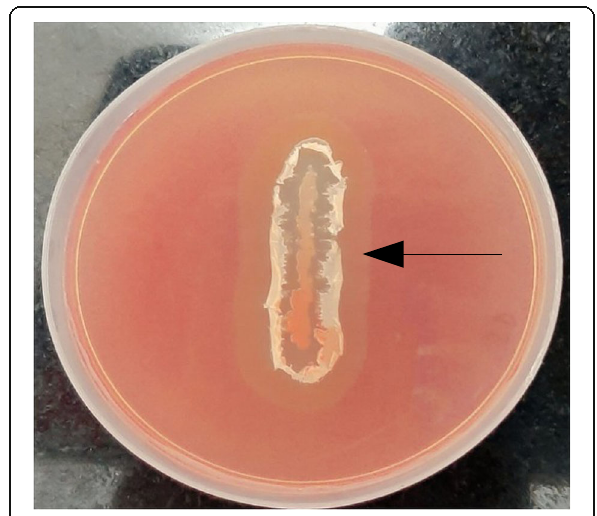
Fig. 1 Cellulase activity by B. subtilis : B. subtilis culture when grown on CMC agar gives zone of clearance due to cellulase production